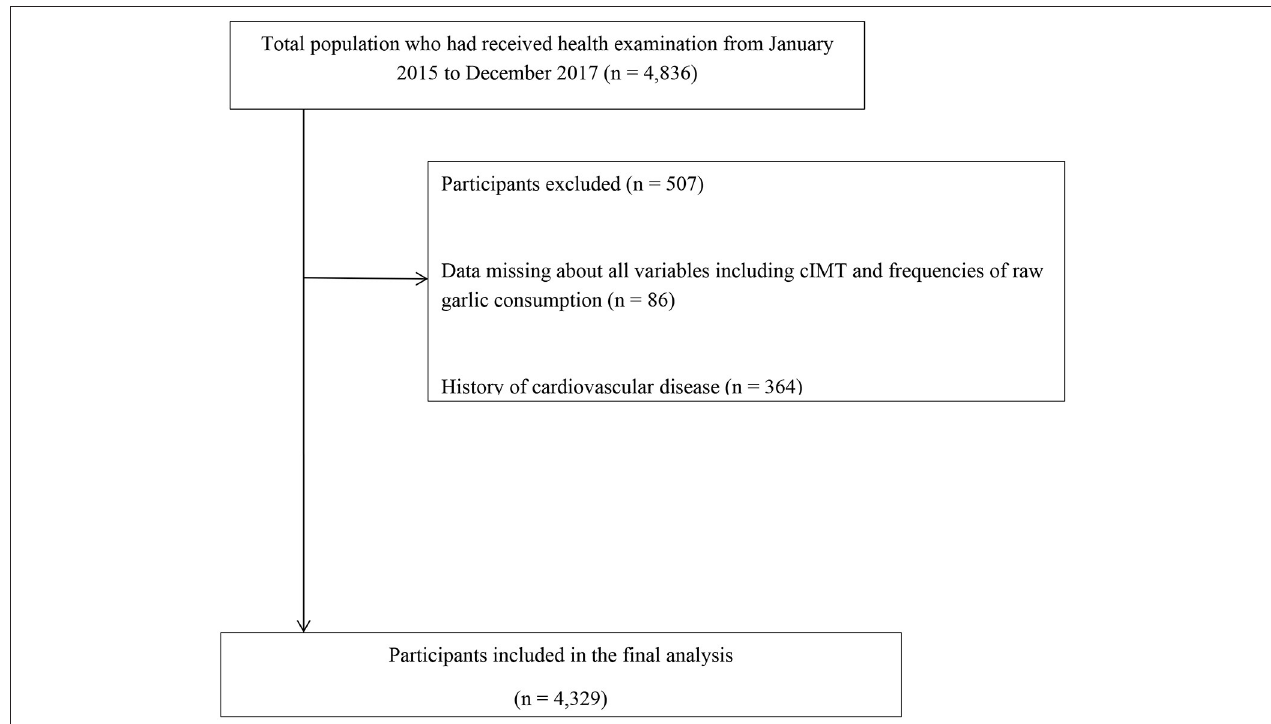
FIGURE 1 | Flow diagram of the participants’ selection for the study of association between raw garlic consumption frequency and thickened intima media thickness.